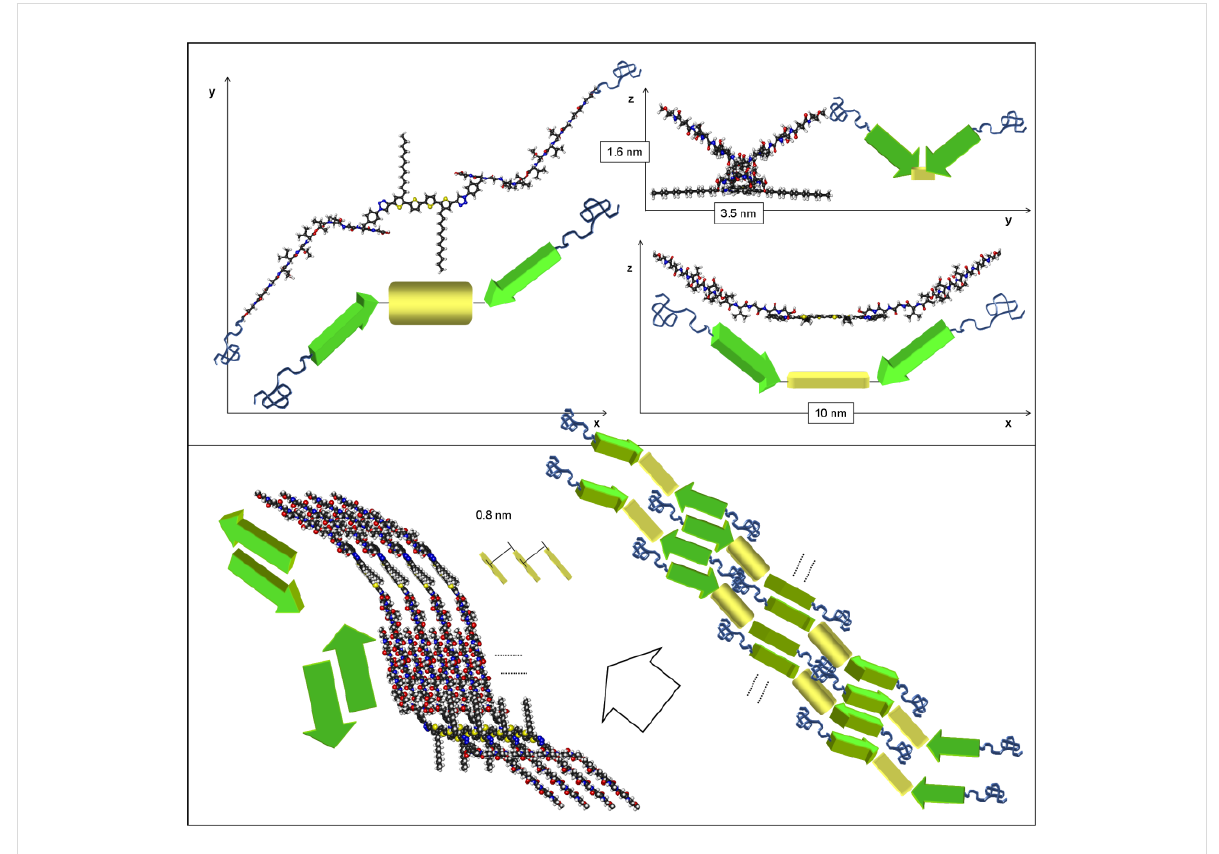
Figure 8: Calculated minimum energy conformation of oligothiophene–oligopeptide hybrid 1' in the three Cartesian directions (top). Calculated model of an ensemble of eight molecules (bottom, left) as well as a model cartoon (bottom, right). White arrow shows the fiber growth direction [22].